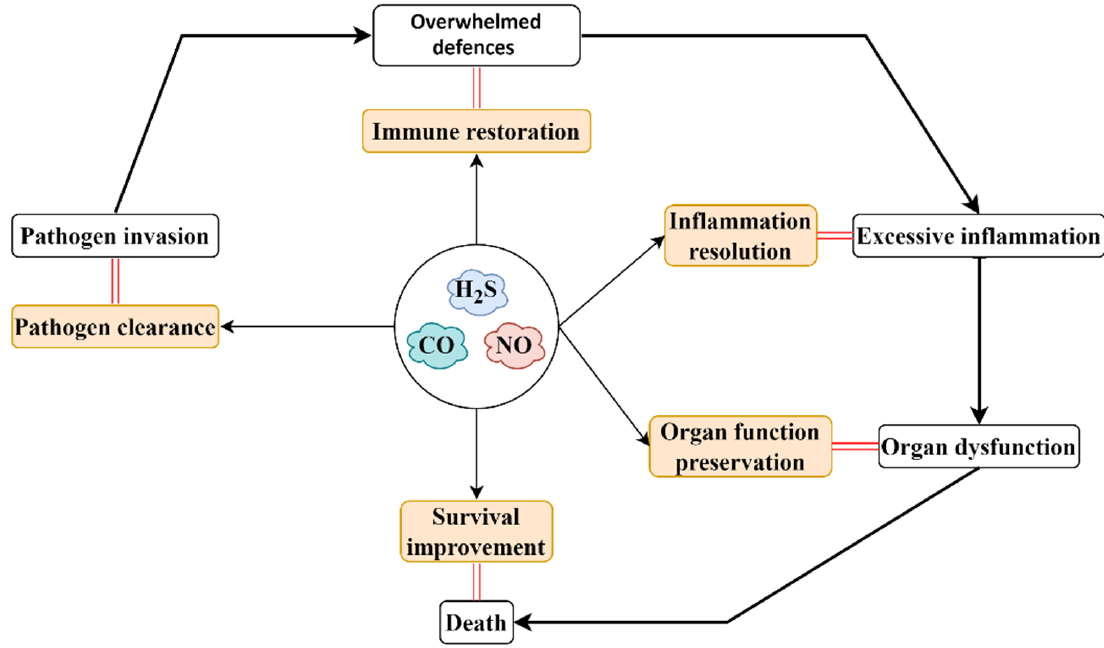
Figure 3. Therapeutic perspective of NO, CO and H 2 S in sepsis. Multiple organ dysfunction resulting from excessive inflammation caused by an aberrant host defense response directed at invasive pathogens and their toxins is one hallmark of sepsis, which can eventually lead to death (as shown in white boxes). To promote the survival of sepsis, several medical countermeasures targeting sepsis pathophysiology, including pathogen clearance, immune restoration, inflammation resolution and organ function preservation, have been developed (as shown in light orange boxes). While the feasibility, safety and efficacy of NO-, CO- and H 2 S-based treatments should be further assessed, the therapeutic promise of gaseous-mediator-based treatments has been observed in many investiga- tions.